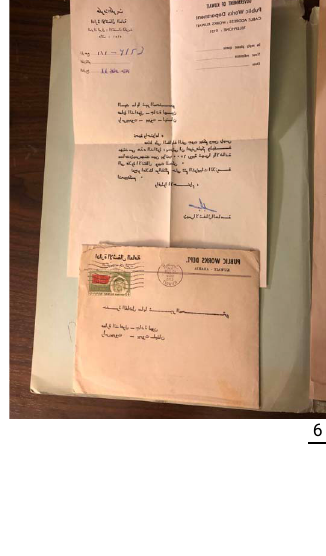
Sheikh Abdullah III al-Salem al-Sabah (Emir of Kuwait 1950- 65) in Cairo meeting with other Arab leaders including Nasser at the background. Source: Life International (Oct. 4th, 1965) courtesy to Shiber Archive, Washington, DC. ©